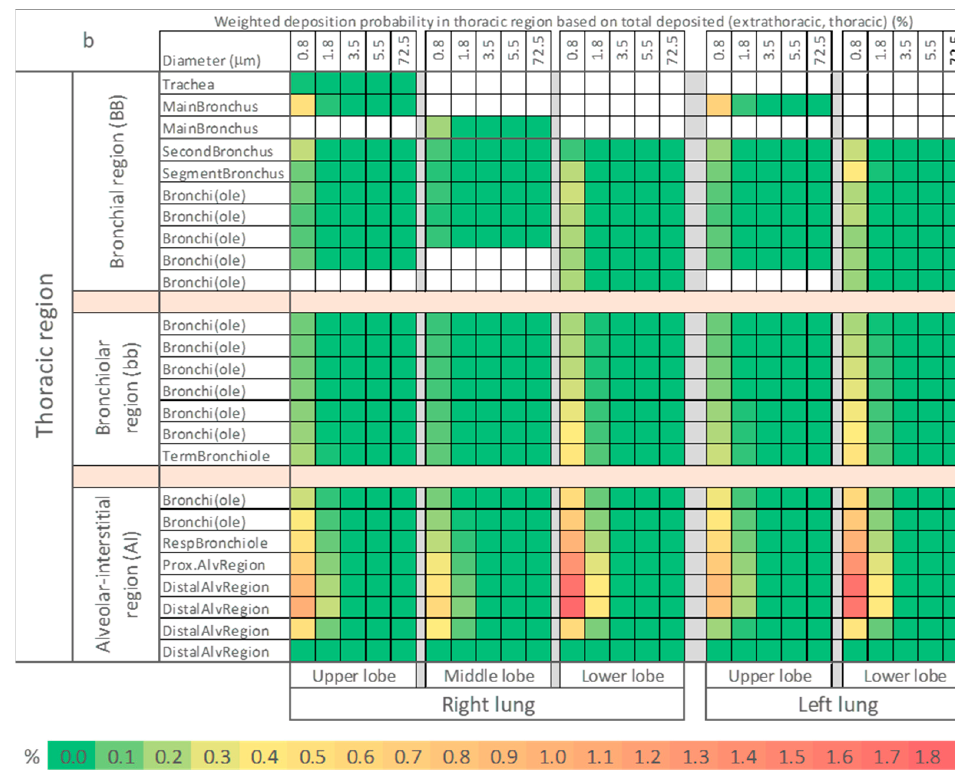
Figure 6. Heat map for the probability of ARAP deposition in the thoracic region based on total deposited particle number (extrathoracic, thoracic). Shown are all thoracic sub-structures and all ARAP modes. As lobes have different numbers of generations, the sub-structures were aligned. Common structures are indicated on the far left. Probability is color-coded according to legend.